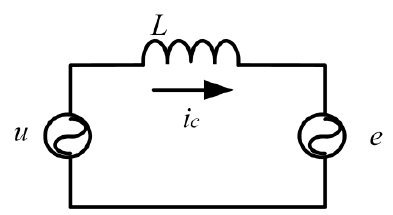
Figure 6. The equivalent circuit of the APF device.